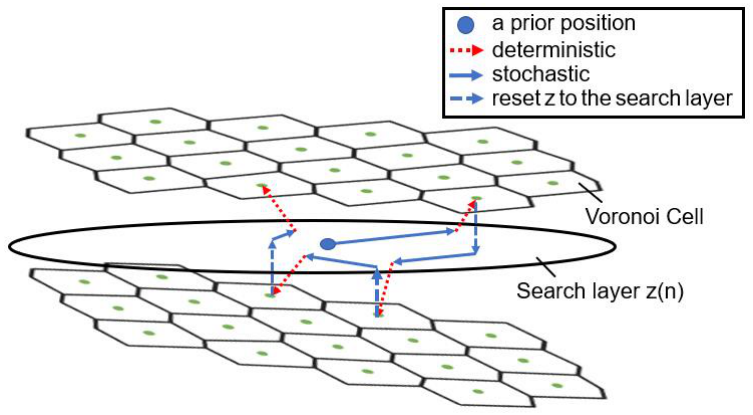
Figure 3. Illustration of search procedure on a particular search